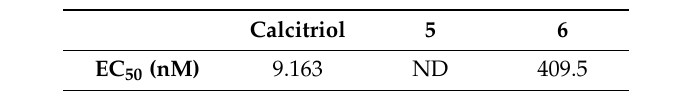
Table 3. Induction of CD11b expression by calcitriol and analogs a